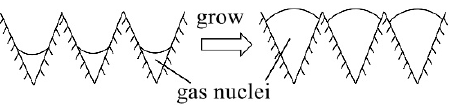
Figure 12. Schematic diagram of growth of gas nuclei in hydrophobic microstructure.